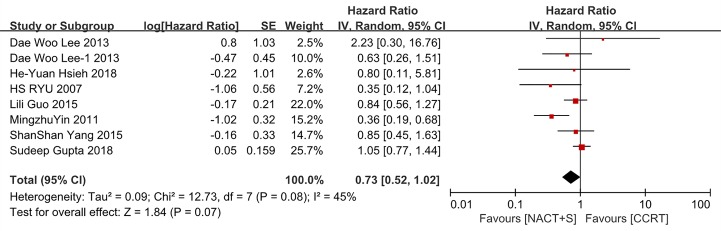
Forest plot of overall survival (OS) for patients with stage IB2-IIB cervical cancer.